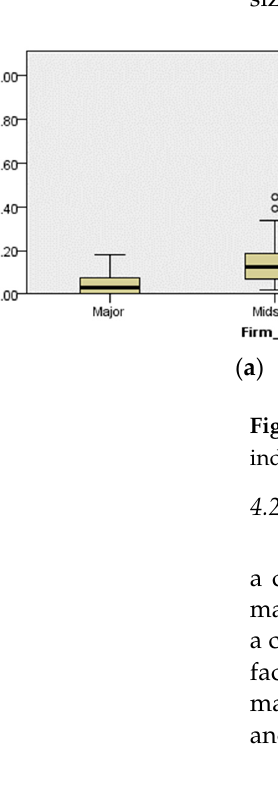
Table 6. Effect of capital structure on profitability